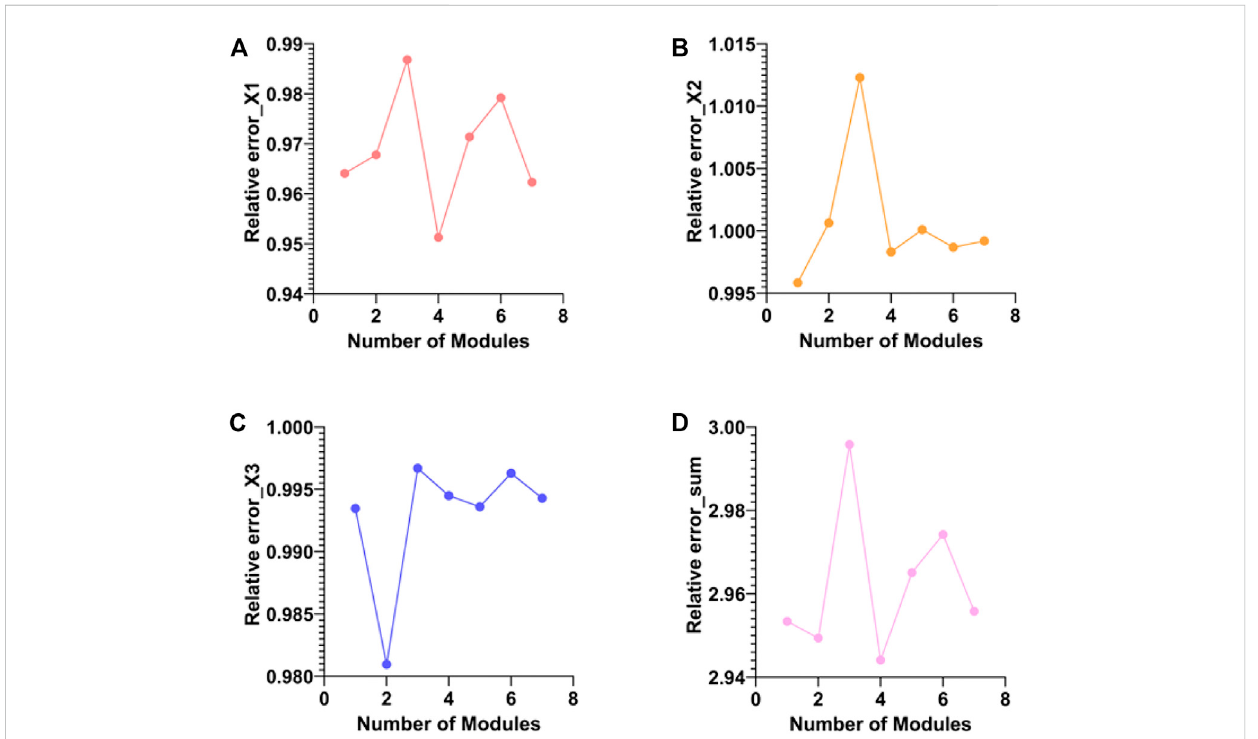
FIGURE 4 Comparison of Pearson correlation coef fi cients of three elements in different modules. (A – C) are the absolute values of the Pearson correlation coef fi cients between the original and reconstructed matrices of WSI, miRNA, and mRNA for different modules, respectively. (D) is the mean of the absolute value of the Pearson correlation coef fi